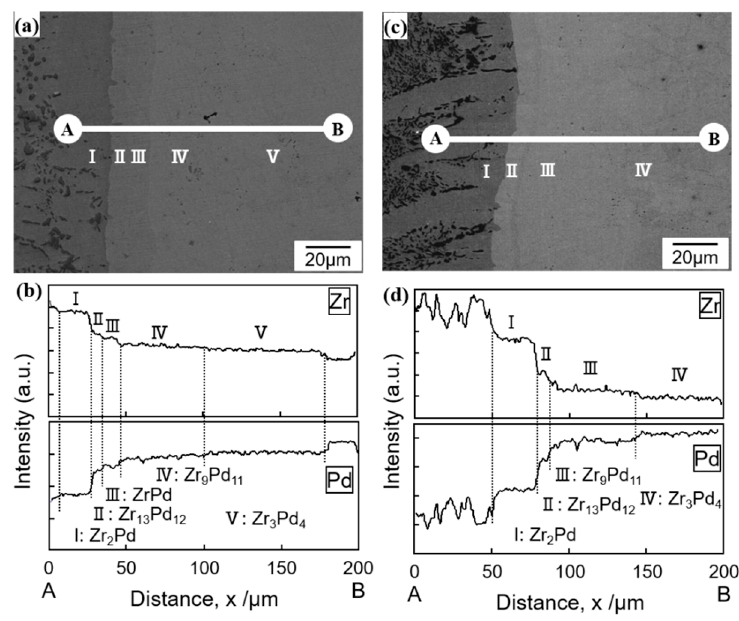
Figure 8. ( a , b ) SEM image and the corresponding concentration–penetration curves by electron probe microanalysis in the vicinity of the diffusion zone in Zr-15 atom % Pd/Zr-60 atom % Pd couple annealed at 1033 K for 3600 ks, respectively. There are four concentration gaps corresponding to Zr 2 Pd/Zr 13 Pd 12 , Zr 13 Pd 12 /ZrPd, ZrPd/Zr 9 Pd 11 , and Zr 9 Pd 11 /Zr 3 Pd 4 boundaries by the intensity ration of Zr and Pd. ( c , d ) SEM image and the corresponding concentration–penetration curves by electron probe microanalysis in the vicinity of the diffusion zone in Zr-15 atom % Pd/Zr-60 atom % Pd couple annealed at 1023 K for 3600 ks. There are three concentration gaps corresponding to Zr 2 Pd/Zr 13 Pd 12 , Zr 13 Pd 12 /Zr 9 Pd 11 , and Zr 9 Pd 11 /Zr 3 Pd 4 boundaries. ZrPd compound exists in the specimen aged at 1033 K, as shown in ( a , b ), but there is no ZrPd compound in the specimen aged at 1023 K, as shown in ( c , d ).